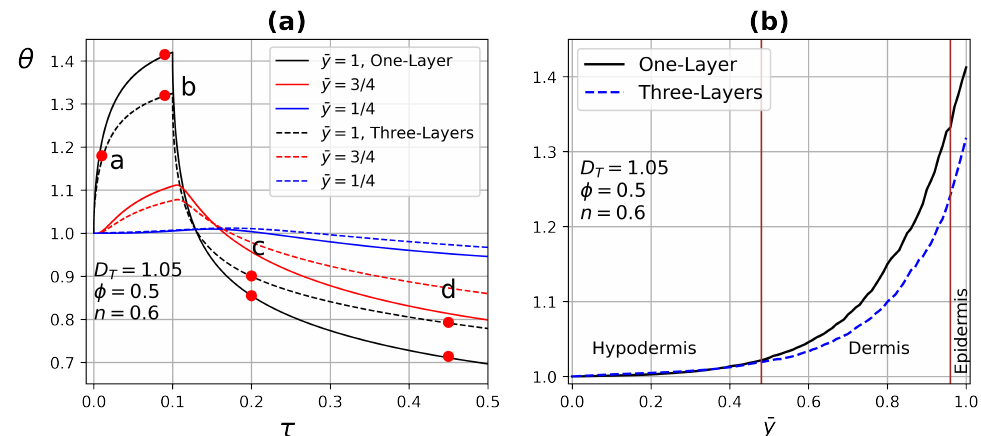
Figure 16. Temperature profile comparison between one- and three-layer tissue as a function of ( a ) time at three different depths of the tissue and ( b ) depth of the three-layer tissue with different porosities φ = 0, 0.5, and 0.05 for epidermis, dermis, and hypodermis, respectively.